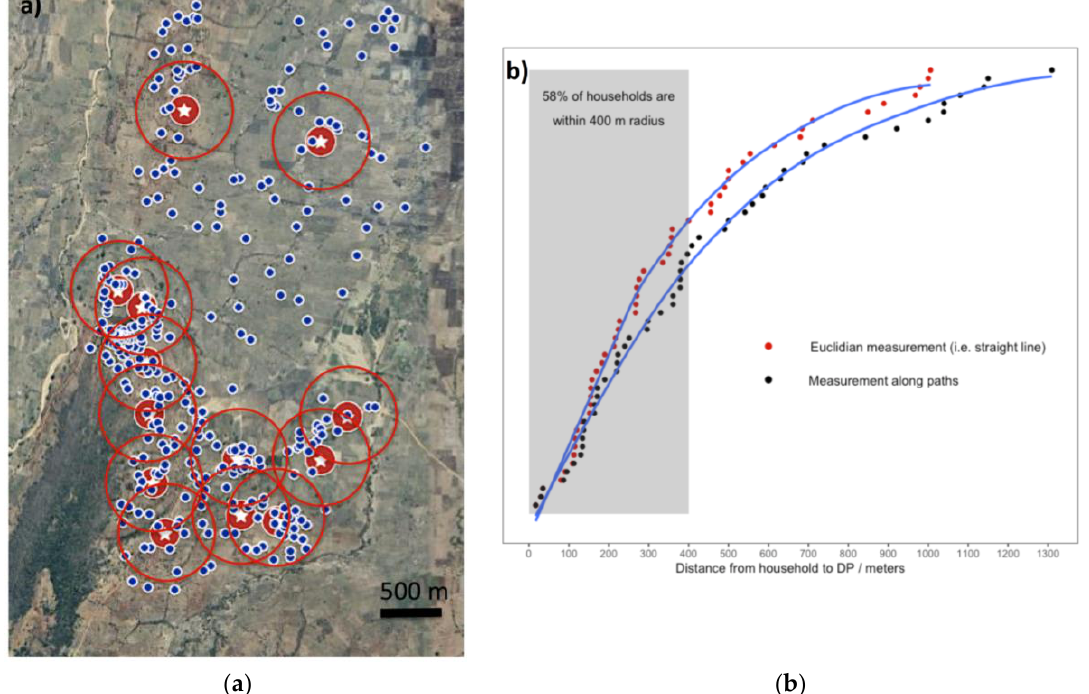
Figure 1. ( a ) DPs in Community A with 400 m radius (red) and all household locations (blue); ( b ) Distribution of distances between households and DPs for sampled user households.